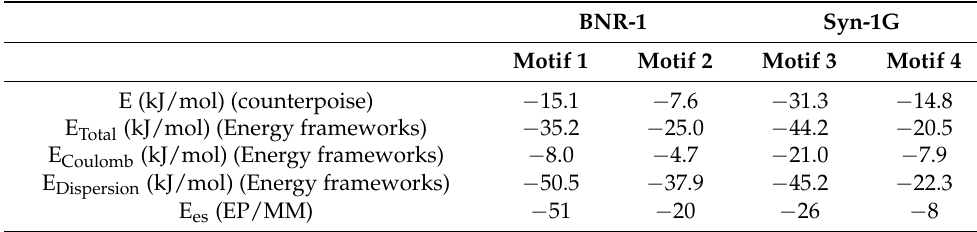
Table 3. Summary of interaction energies (kJ mol − 1 ) of the most important motifs in BNR-1 and Syn-1G calculated with different methods. Methods are described in Section 3.6.1